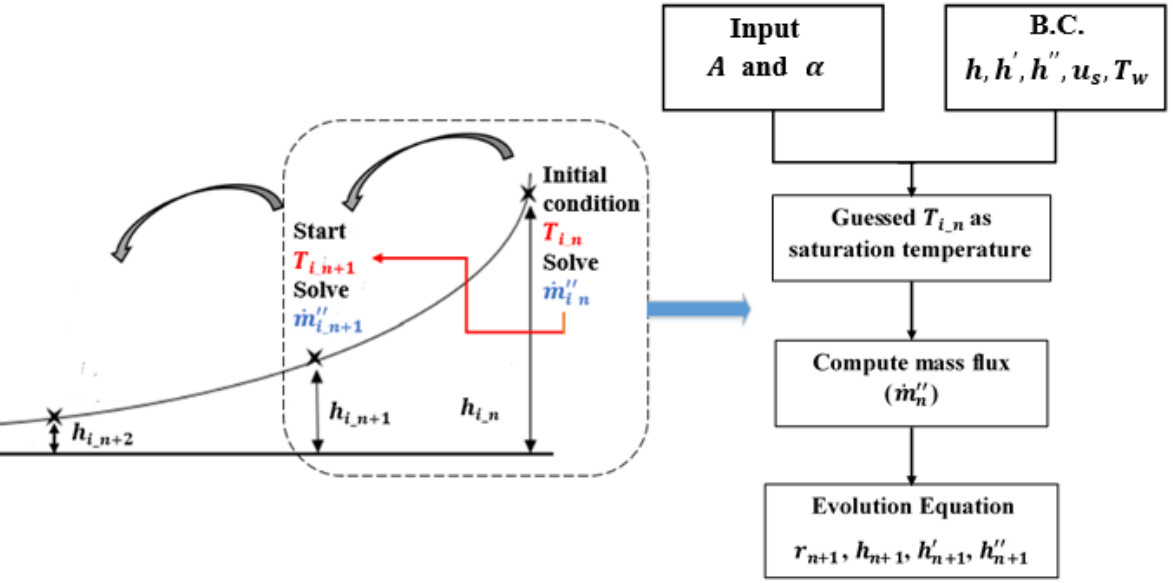
Figure 4. Solution setup used to solve the interfacial temperature and evaporative mass flux in the thin